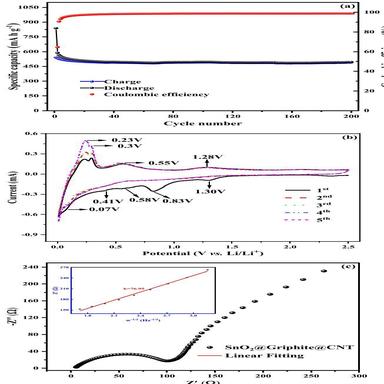
The (a) cycling performance, (b) cyclic voltammogram and (c) Nyquist plots of the composite electrode.